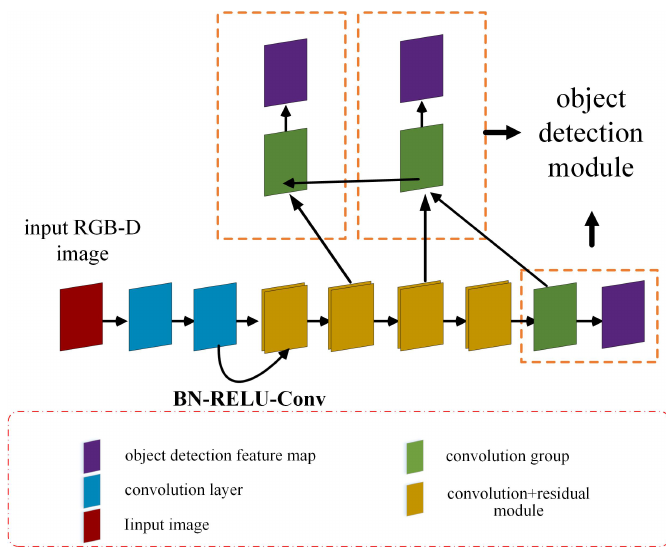
Figure 3. Flowchart of the network pruning procedure.